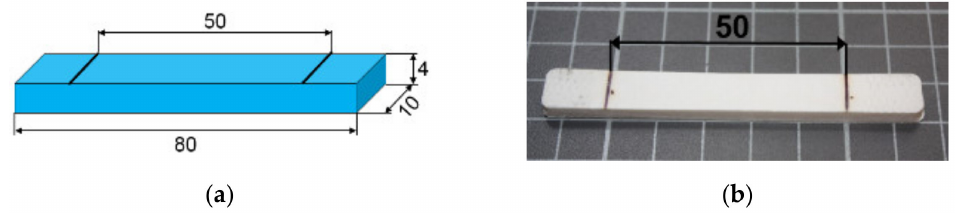
Figure 1. ( a ) Scheme of investigated rectangular samples; and ( b ) the image of fabricated bars with a marked central area width of 50 mm which was subjected to